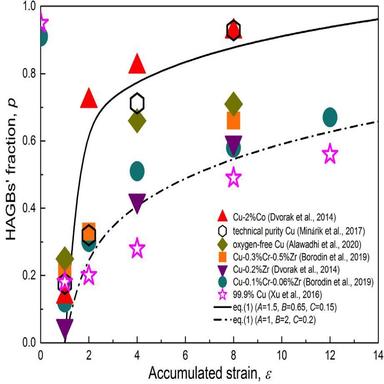
Fraction of high-angle grain boundaries as a function of accumulated plastic strain for copper alloys processed by ECAP. Symbols depict experimental data; curves calculated by Eq. (1).